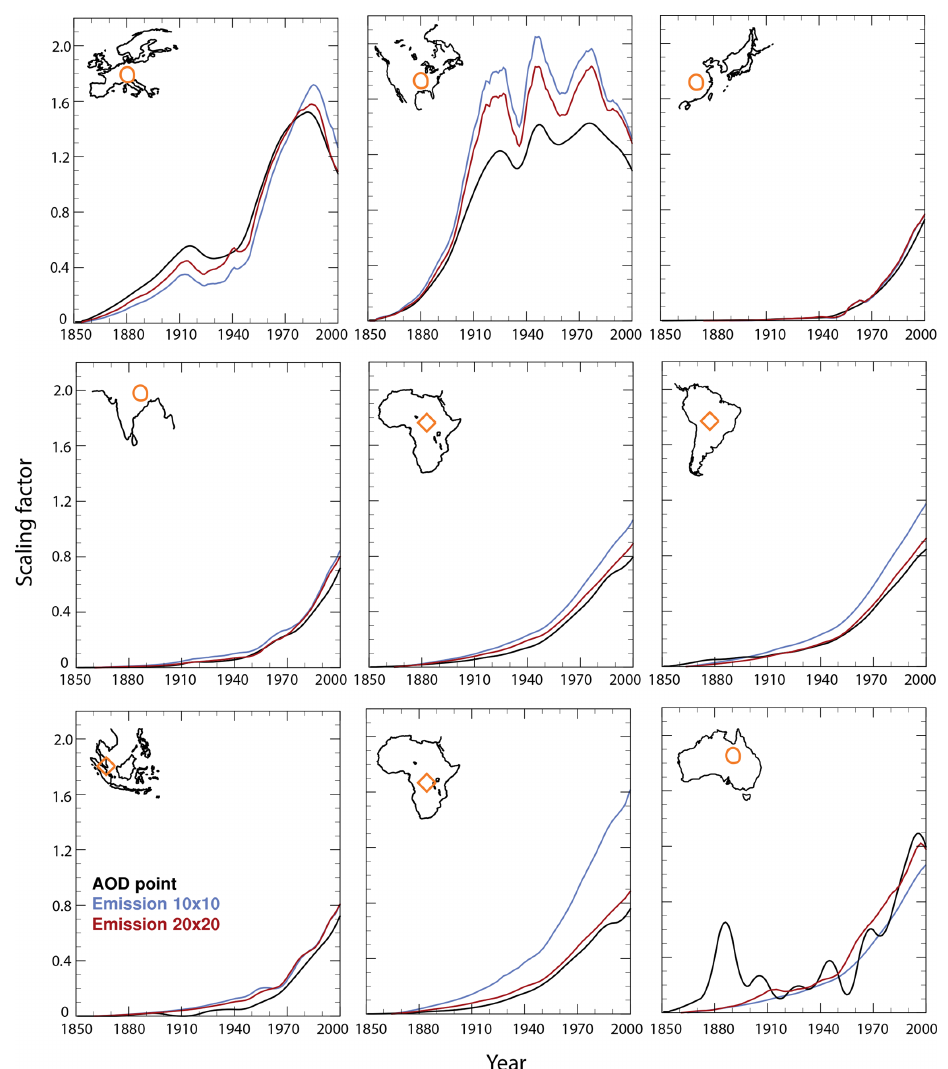
Figure A1. Scaling factor comparison. Shown are annual scaling factors E i (t) derived from (black) the aerosol optical depth in the plume centres of a transient ECHAM-HAM simulation using a pre-existing aerosol emission database, and (colours) the anthropogenic aerosol emissions of that simulation, averaged over grid boxes around the plume centres. The geographical positions of the plumes with industrial pollution (circles) and biomass burning (rectangles) are